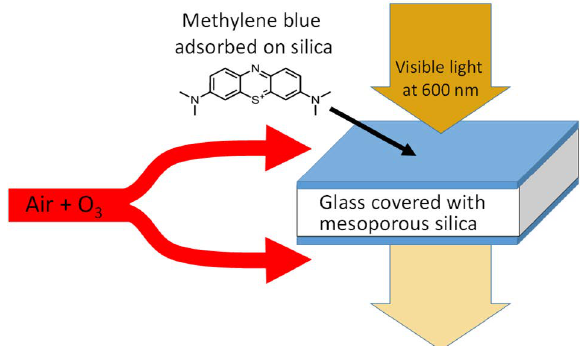
Figure 1. Principle of the sensor. A glass slide is covered on both sides with a mesoporous silica thin film on which methylene blue is adsorbed. Visible light at 600 nm is absorbed by this colored material. Exposure to O 3 in the atmosphere leads to an immediate degradation of the dye. The kinetic of absorbance decrease is immediately translated to a concentration.